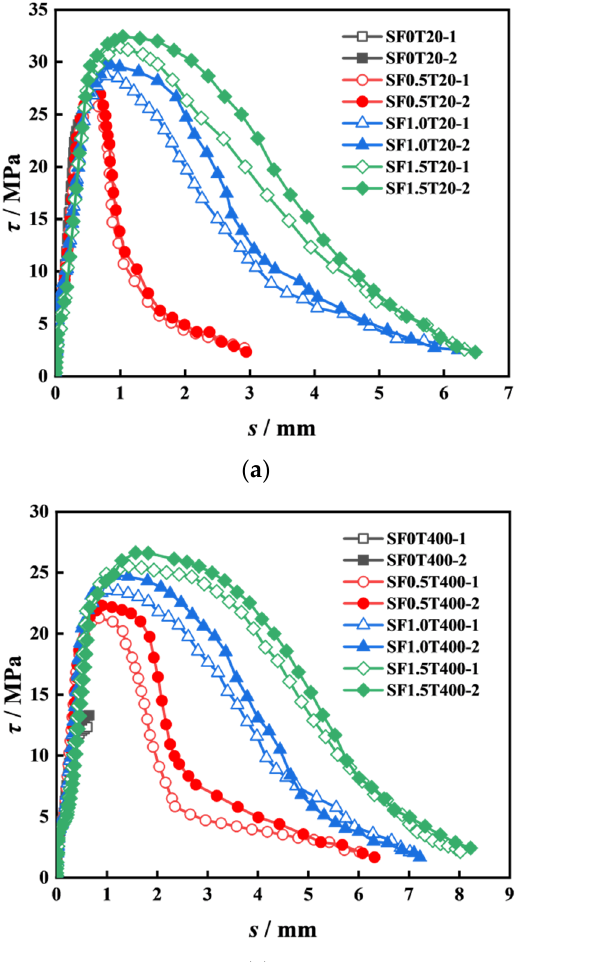
Figure 9. Bond–slip curves of SFRC.